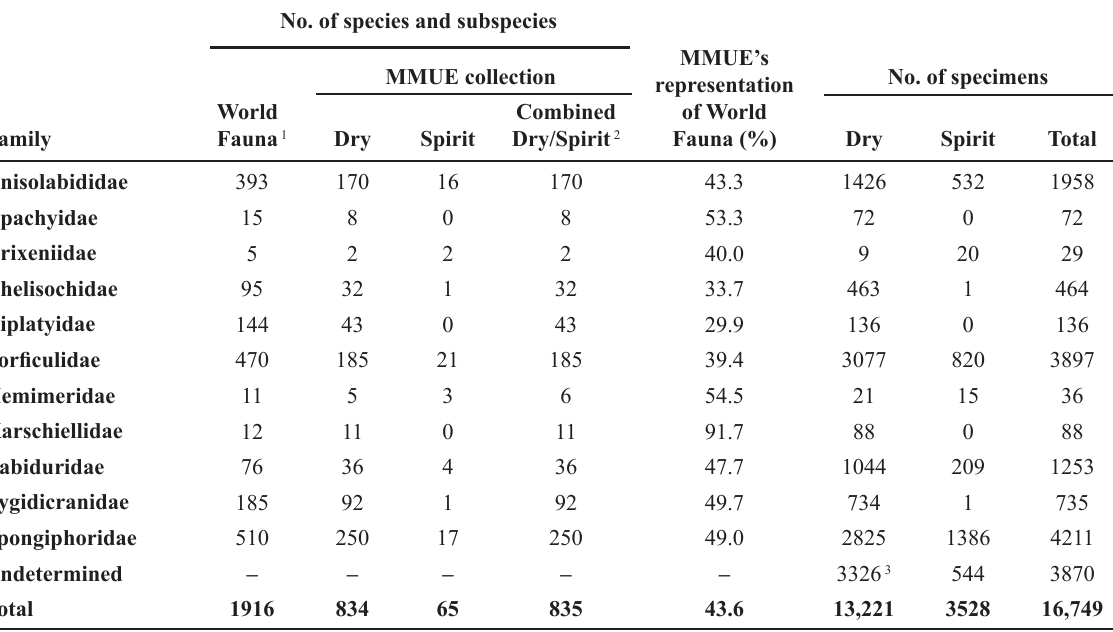
Table 1. Composition of the Manchester Museum’s Dermaptera